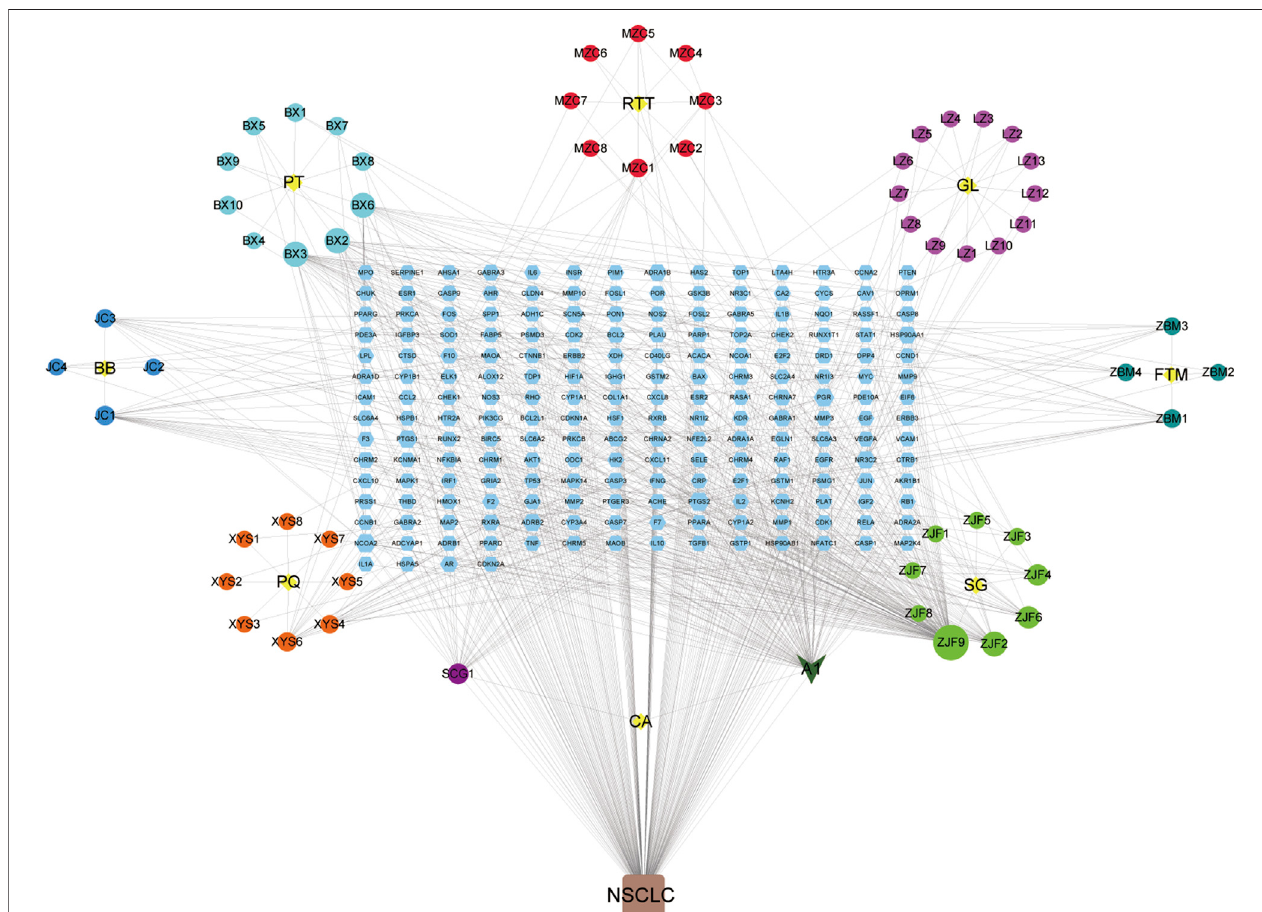
FIGURE 4 | Chemical constituent targets of YFSJ and NSCLC-related genes network. The yellow nodes are eight botanical drugs of YFSJ, and the circular nodes are constituents of each drug. A1 was a shared constituent among the three ( Pinellia ternata ( Thunb. ) Makino [ Araceae ; Pinelliae rhizoma praeparatum ], Ranunculus ternatus Thunb. [ Ranunculaceae ; Ranunculi ternati radix ], and Cremastra appendiculata ( D.Don ) Makino [Orchidaceae; Cremastrae pseudobulbus , Pleiones pseudobulbus ] botanical drugs. The rectangular nodes are targets of chemical constituents.(PT: Pinellia ternata ( Thunb. ) Makino [ Araceae ; Pinelliae